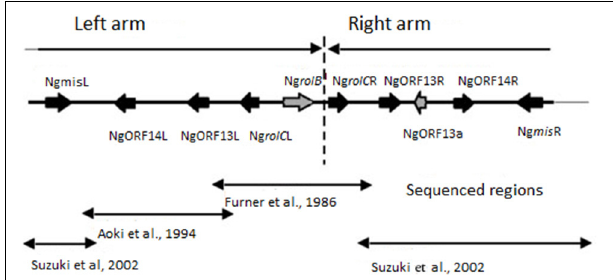
FIGURE 1 | Structure of cT-DNA in the Nicotiana glauca genome (based on Suzuki et al., 2002). The cT-DNA and its flanking regions are indicated. Lines with a single arrowhead indicate the imperfect inverted repeat. Lines with arrowheads at both ends indicate regions sequenced by each of three